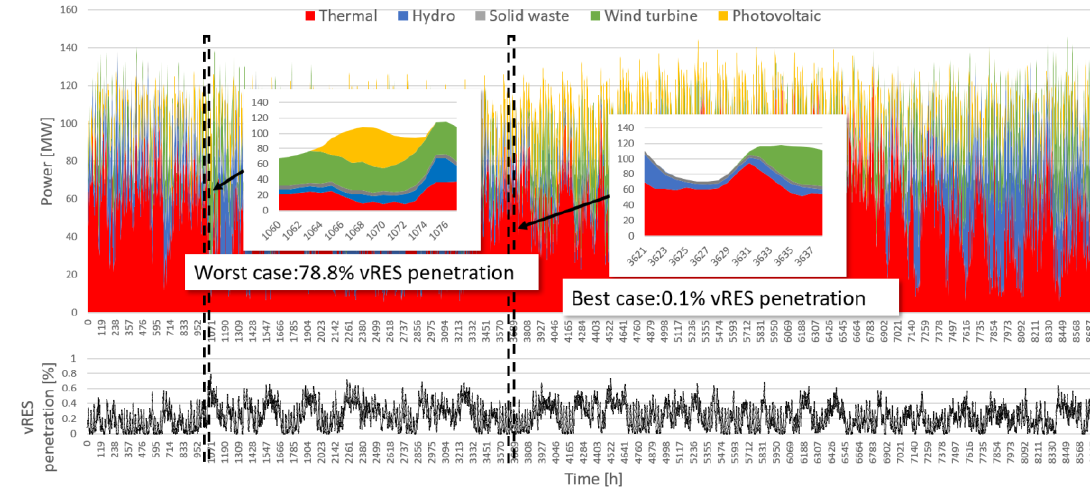
Figure 4. Resulting best and worst cases from the yearly optimal power flow (OPF) of the reference scenario.